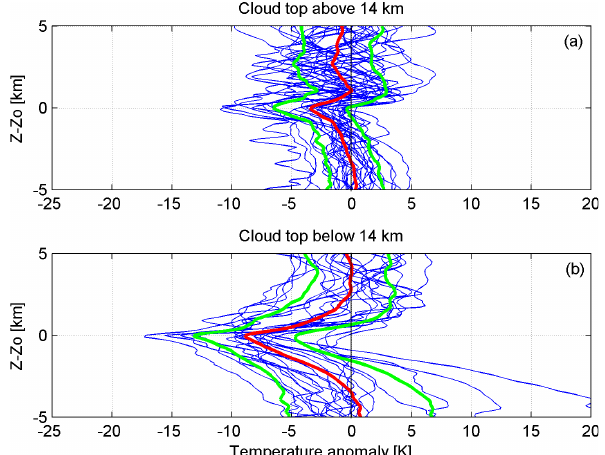
Fig. 8. Vertical profile of the GPS temperature difference between the convective system and the background climatology, calculated with respect to the altitude of the cloud top derived from the cor- responding CALIOP measurements. Blue lines show each of the 53 cases, separated according to cloud top above and below 14km. The red line is the average and the green lines are the average ± one standard